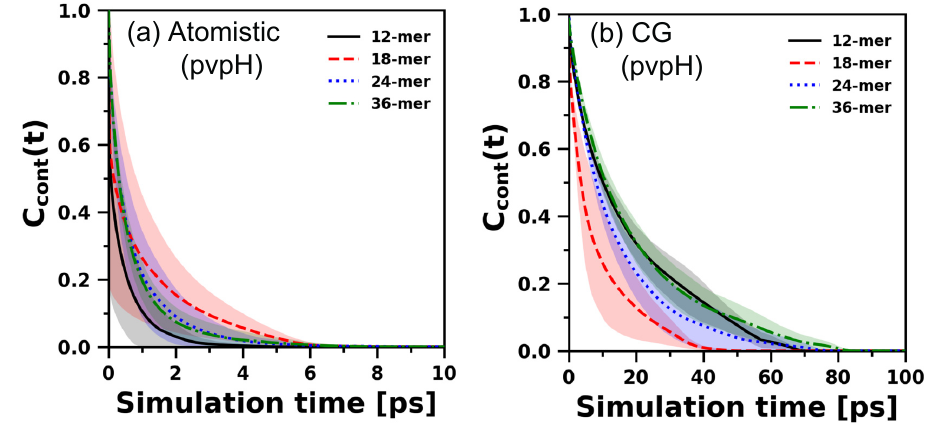
Figure 9. Comparison of continuous hydrogen bonding time autocorrelation function obtained from both atomistic ( a ), and CG simulations (with best performing parameters) ( b ) for pvpH chains, of chain length 12-mer, 18-mer, 24-mer and 36-mer. The average autocorrelation functions and standard deviations (shown as shaded region) are computed from the means of 3 independent trials for both atomistic simulations and CG simulations. This CG simulation C cont (t) is calculated using a H–H attraction potential cuto ff distance criterion of 1.50 σ HH (0.45 d); Figure S24 of SI shows that the behavior of C cont (t) changes with a change in this cutoff distance.